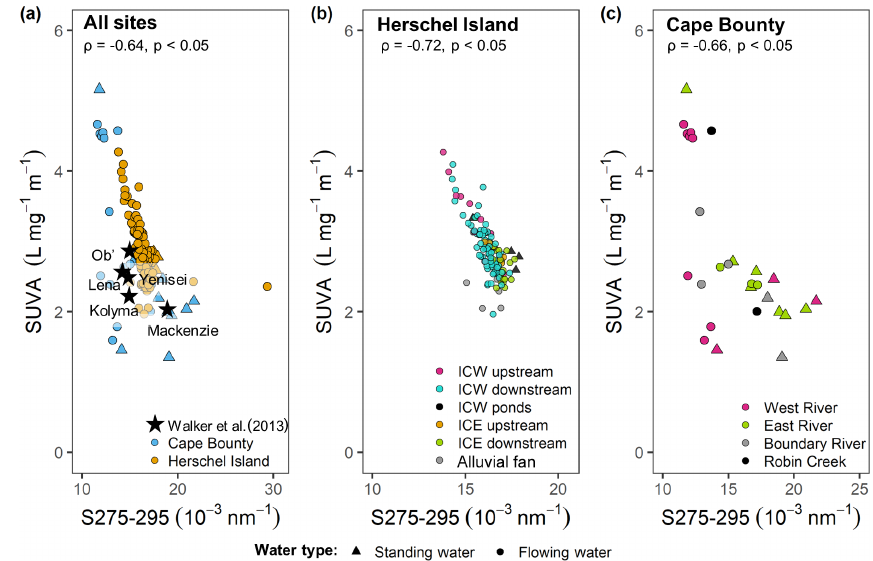
Figure 4. Slope of coloured dissolved organic matter ultraviolet cDOM UV absorption 275–295 (10 − 3 nm − 1 ) versus specific ultraviolet absorbance SUVA (Lmg − 1 m − 1 ) for (a) all sites, (b) sites on Herschel Island depicting the sampling locations Ice Creek West (ICW) upstream, downstream, and ponds; Ice Creek East (ICE) upstream, downstream, and alluvial fan; and (c) sites at Cape Bounty (West River, East River, Boundary River, Robin Creek). Note that flowing water is indicated by a circle while standing water such as lakes or ponds is indicated by a triangle. Midflow SUVA and S275–295 values for the large Arctic rivers (Walker et al., 2013) are added to (a)